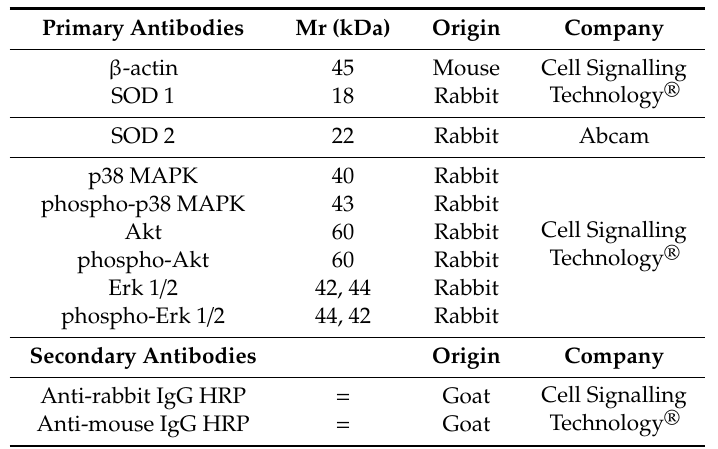
Table 1. List of western blot